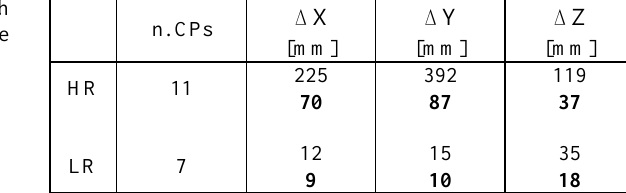
Table 10. Terrestrial photogrammetric block - CPs residual